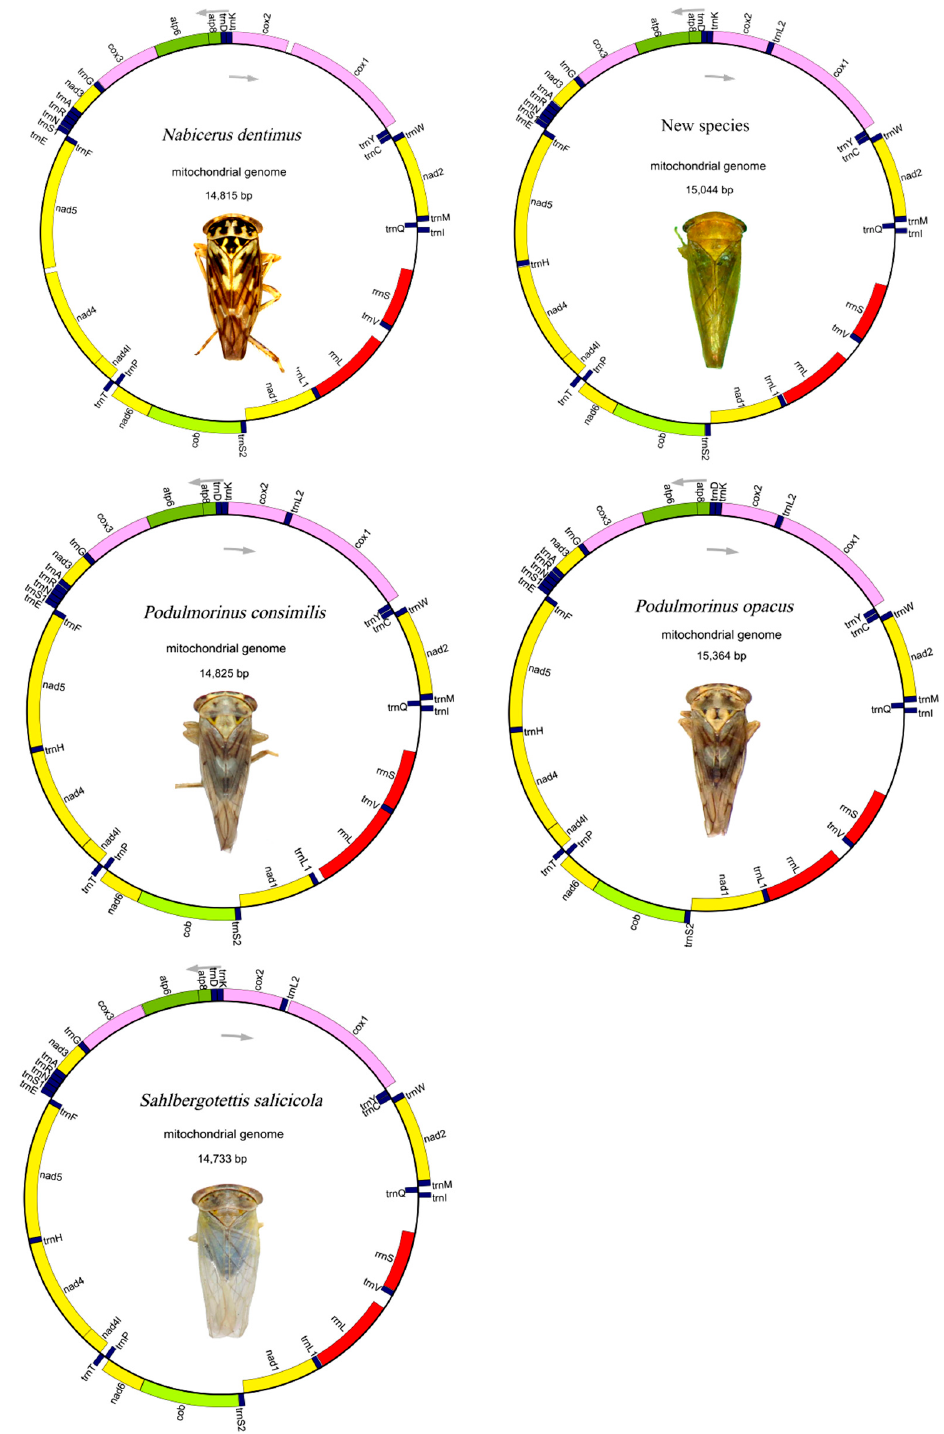
Figure 1. Mitochondrial genome diagram of five Idiocerini species. Genes encoded by the light strand are indicated inside or outside, respectively, showing the direction of transcription. The tRNAs are denoted in blue and labeled according to the one letter amino acid codes. The nucleotide composition, AT skew and GC skew of the total mitogenomes and PCGs of 17 species in the tribe Idiocerini were calculated. The mean AT nucleotide content